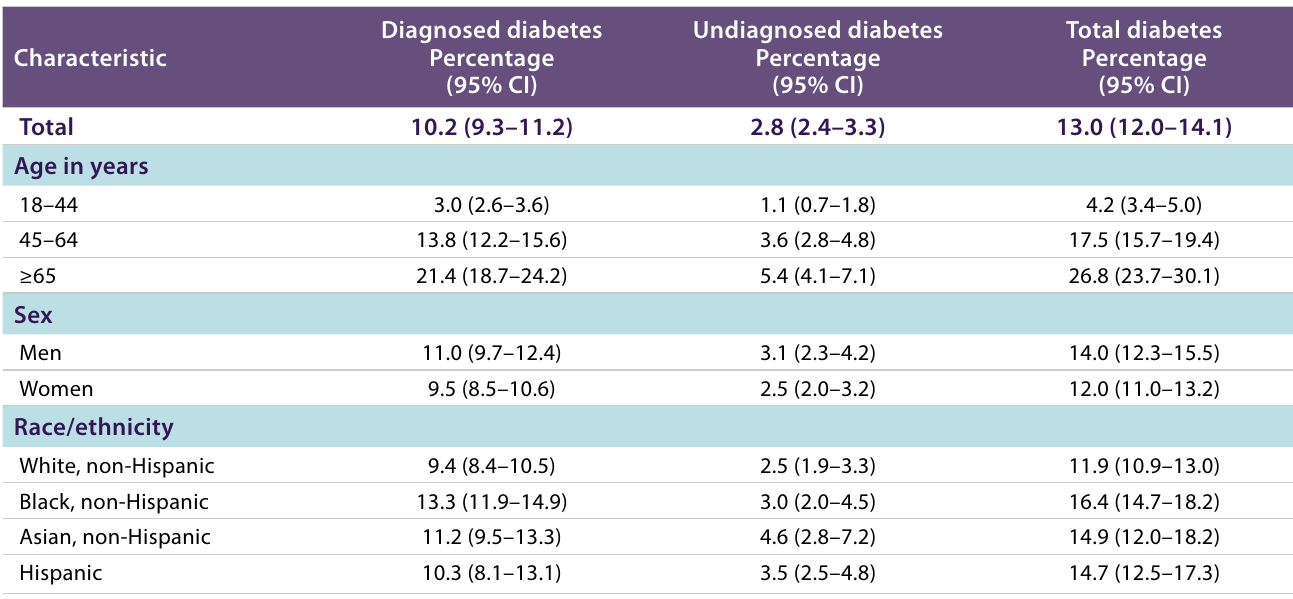
Table 1a. Estimated crude prevalence of diagnosed diabetes, undiagnosed diabetes, and total diabetes among adults aged 18 years or older, United States, 2013–2016 Diagnosed Characteristic